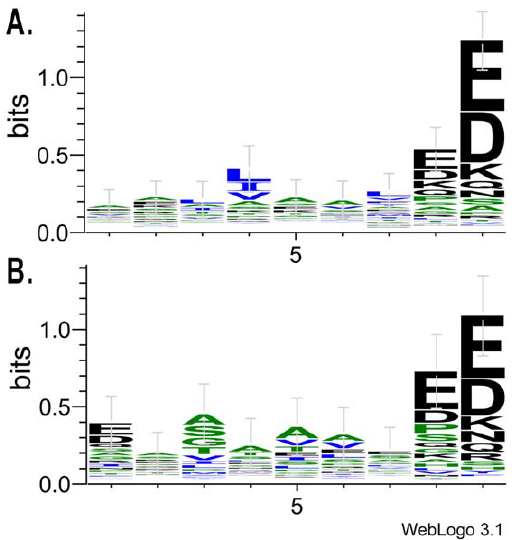
Figure 5. The sequence logos of the core nonamers for (A) I-A g7 and (B) HLA-DQ8.